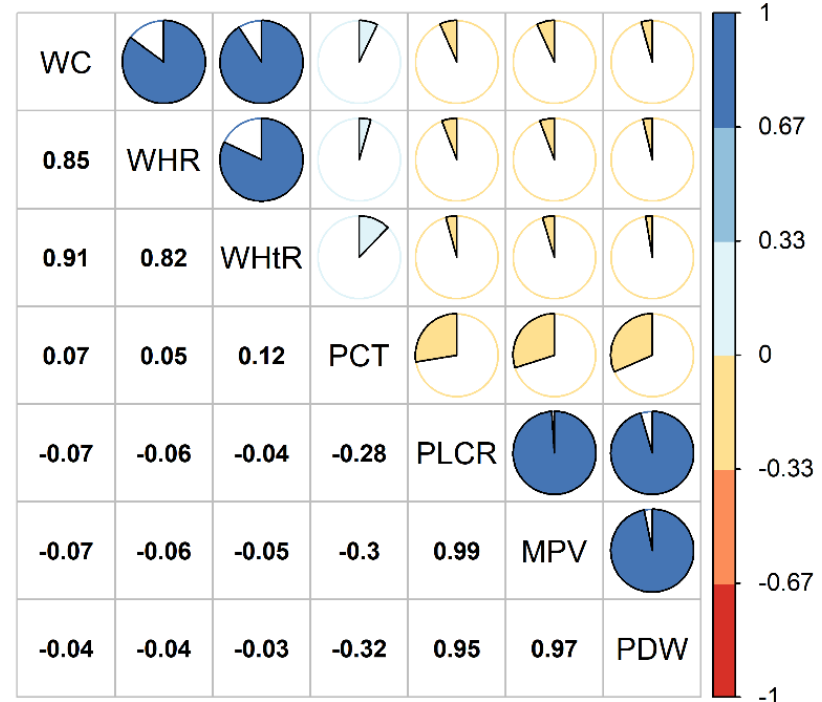
Figure 2. Spearman rank correlation between obesity indices and platelet traits. MPV: mean platelet volume; PCT: plateletcrit; PDW: platelet distribution width; P-LCR: platelet large cell ratio; WC: waist circumference; WHR: waist-to-hip ratio; WHtR: waist-to-height ratio.